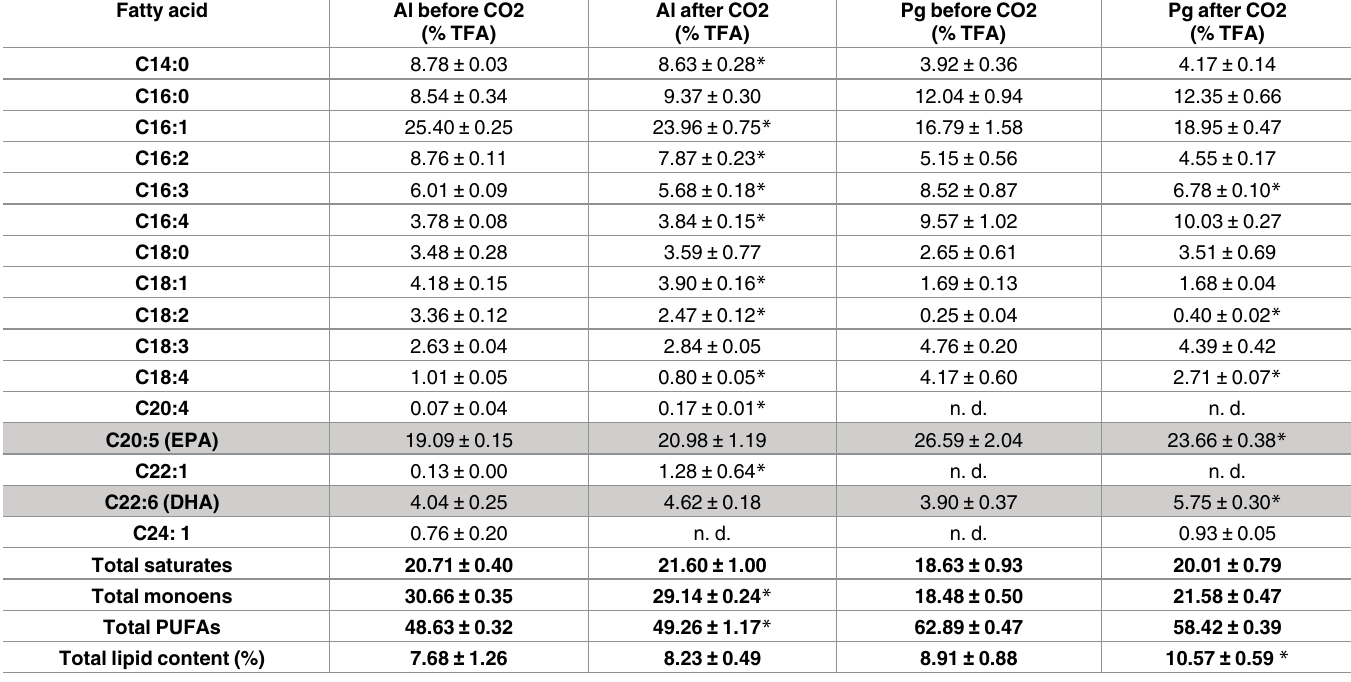
Table 2. Total lipid content and fatty acid composition of A . longicornis (Al) and P . glacialis (Pg) in controls (before CO 2 ) and in CO 2 -treated cul- tures (after CO 2 ). The percentagedisplaysnumbers as proportionof total lipids ± SD (n = 3). Fatty acid Al before CO2 (%